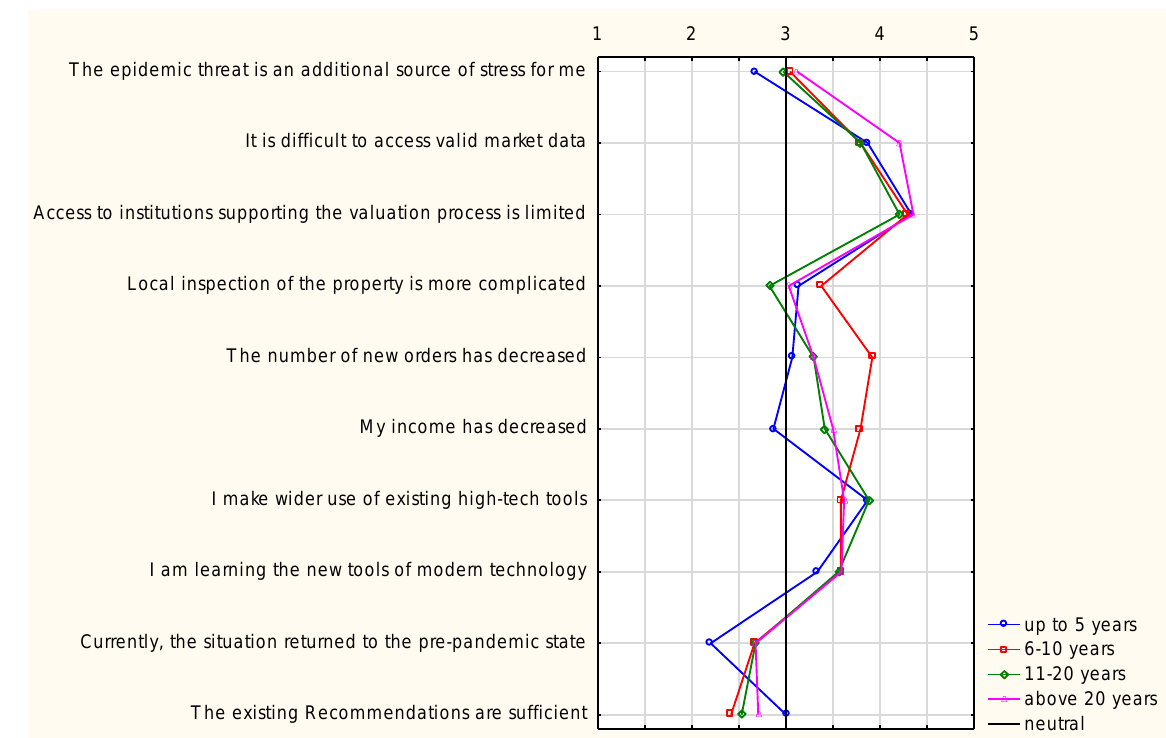
Figure 4. The means of the respondents’ answers in groups by seniority.